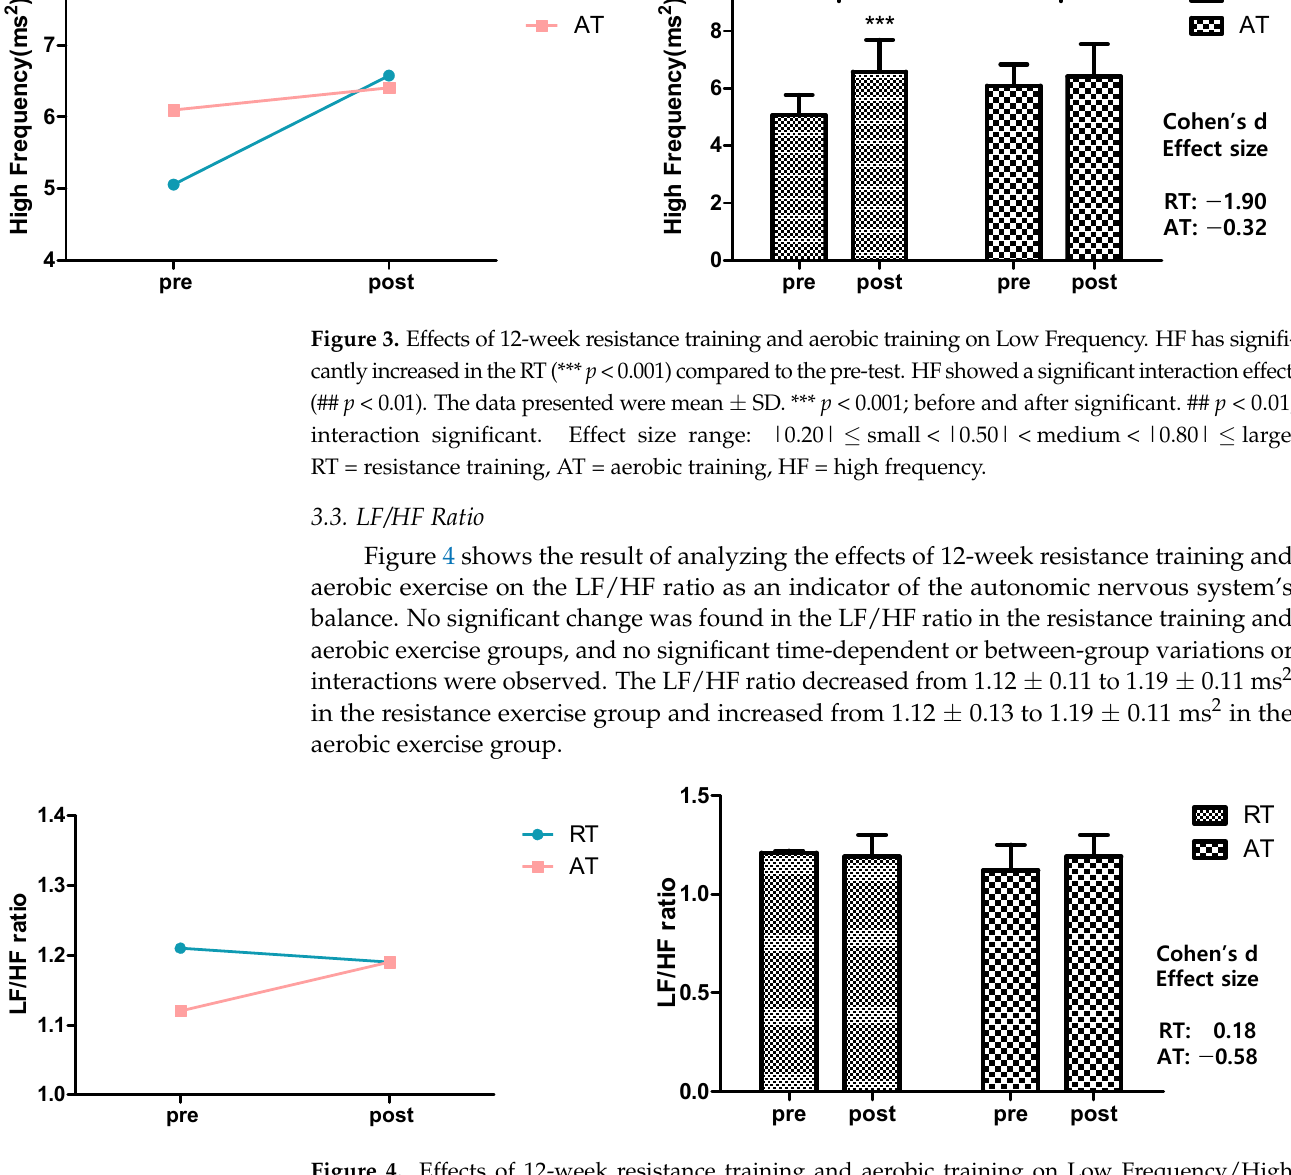
Figure 4. Effects of 12-week resistance training and aerobic training on Low Frequency/High Frequency ratio. LF/HF showed no significant changes in any group. The data presented were mean ± SD. Effect size range: |0.20| ≤ small < |0.50| < medium < |0.80| ≤ large. RT = resistance training, AT = aerobic training, LF = low frequency, HF = high frequency.